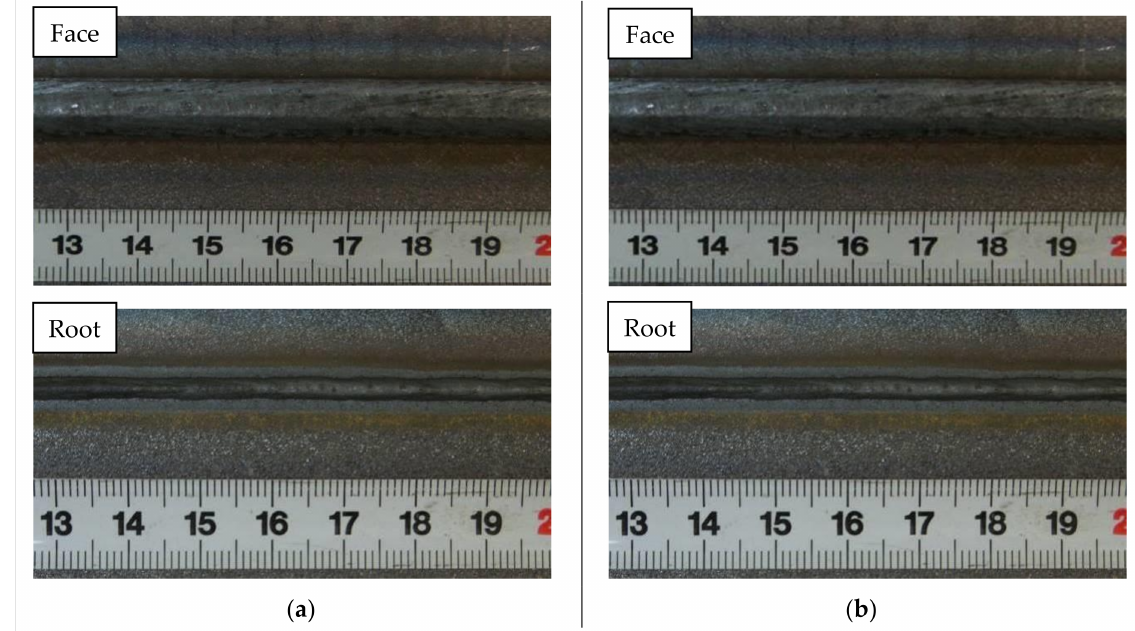
Figure 6. Joint (having thickness 5 mm and 7 mm) viewed from the face side and the root side after the hybrid-welding process: ( a ) joint no. 1 (PA) and ( b ) joint no. 2 (PC) (in accordance with Table